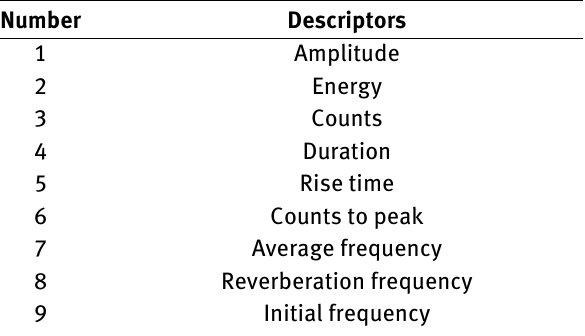
Table 2: List of AE signals